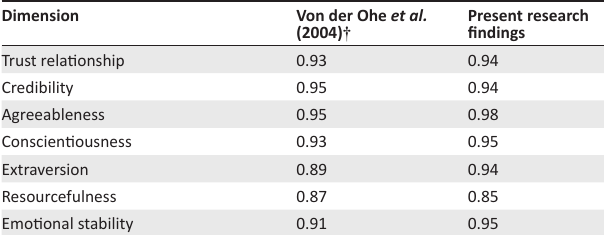
TABLE 2: Comparison of Cronbach alphas between past findings and the present research